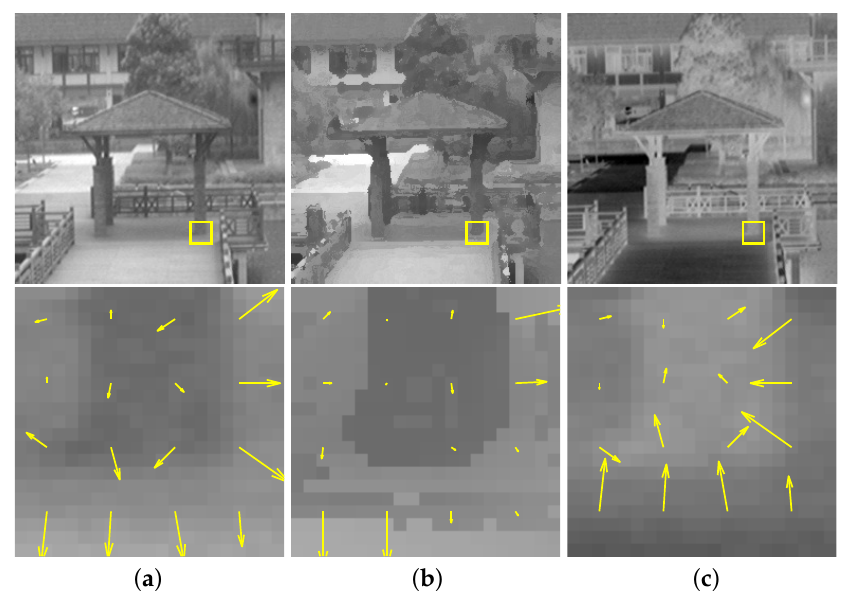
Figure 3. Two types of heterogeneous images: ( a ) original; ( b ) heterogeneous type 1; ( c ) heterogeneous type